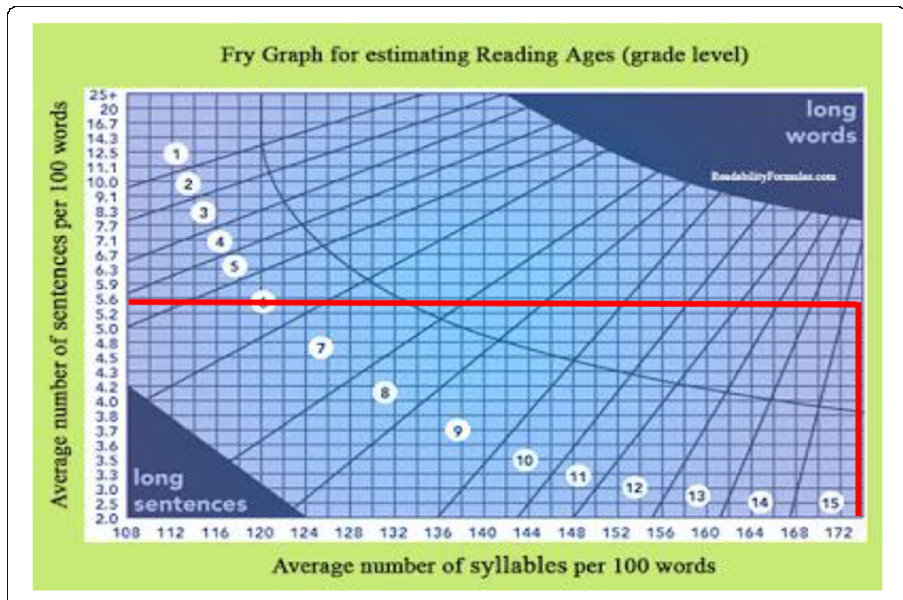
Fig. 3 The results of the e-Book readability test